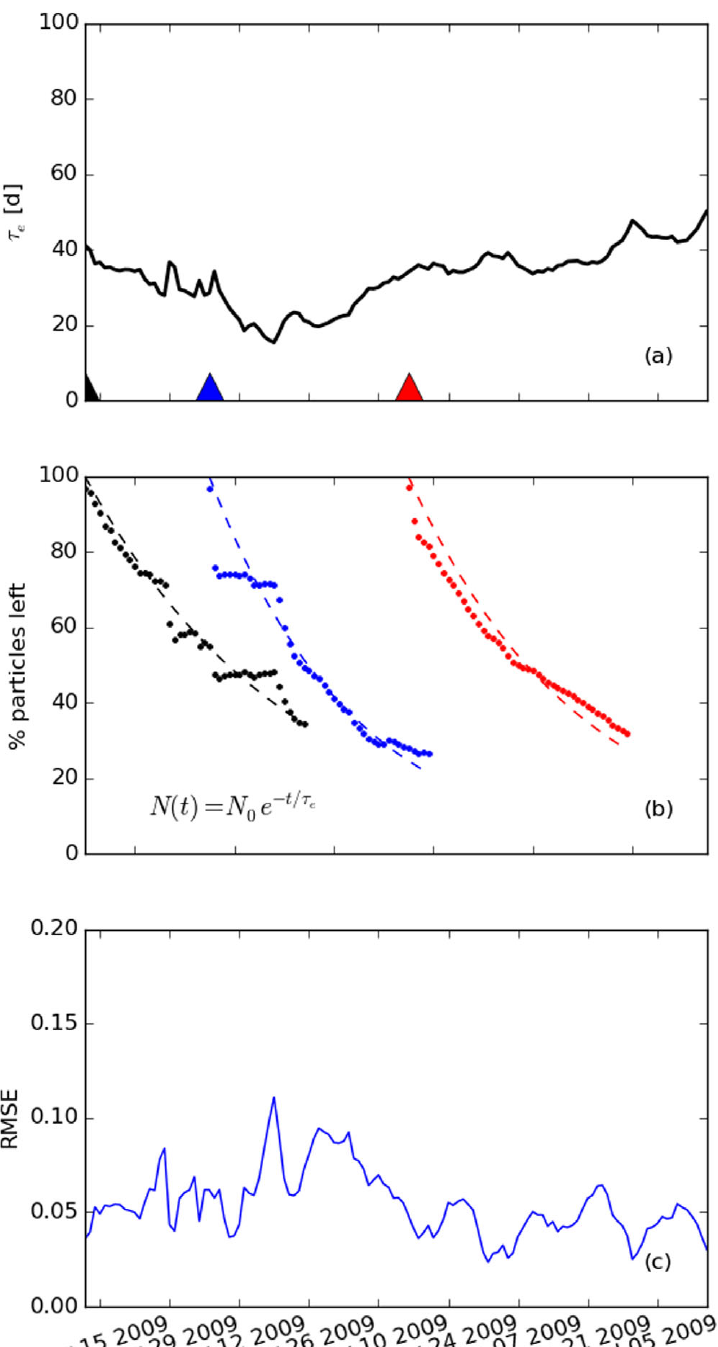
Figure 5. Based on a series of 45-day numerical particle transport simulations of Galveston Bay (TX, USA) by Rayson et al. [100]: ( a ) e -folding flushing times for particles initialized on each day for a period spanning mid-March to mid-July 2009. Triangles represent start times for simulations used for exponential fits shown in ( b ), with the blue triangle representing a high discharge period and the red triangle representing a low discharge period. ( b ) Example exponential fits for particle -tracking simulations with the three di ff erent start times indicated by the triangles in ( a ). Blue (red) dots and and dashed lines represent the model output and curve fit, respectively, for high (low) discharge periods. ( c ) RMSE (root mean square error) of the exponential best fit for all times modeled. (Reproduced with permission from M. Rayson, Journal of Geophysical Research: Oceans; published by Wiley,